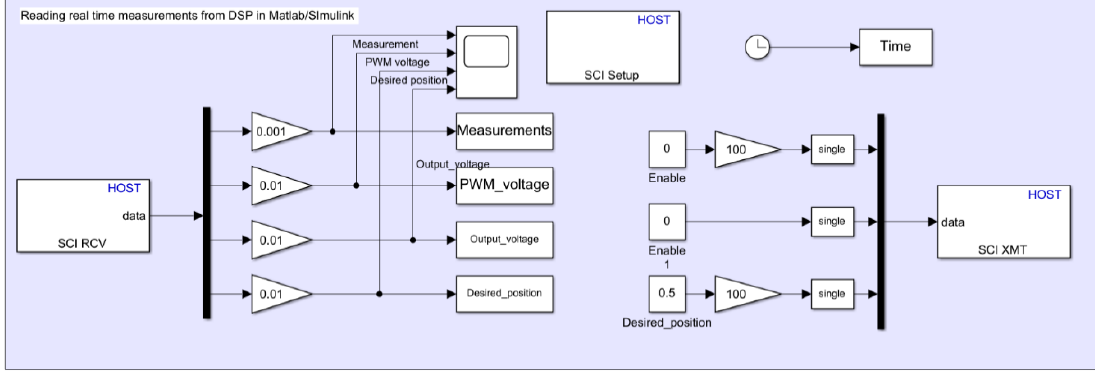
Figure 8. Simulink block inside the ADC_ISR block. Figure 9. Simulink model of the fractional control algorithm with the quasi-anti-windup method. The quasi-anti-windup method resets the discrete transfer function when the output of the approximated discrete 𝑃𝐼 λ 𝐷 𝜇 controller exceeds two times the maximum output from saturation, which represents a force of 4 N. The method proved to be very successful, which becomes more evident in the Results section, where the experimental results are shown. 3. Results The step responses of optimized 𝑃𝐼 λ 𝐷 𝜇 parameters on average had the same rise time, the settling time was approximately 5.5 times faster, and overshoot was nearly elim- inated in comparison to its PID counterpart, as can be seen in Table 1. However, the La- place domain can easily handle fractional orders since derivative is translated into multi- plication and integration into division. Even more, the output of the regulator in the La- place domain is not limited, which means its output can be infinite. Configuring the model